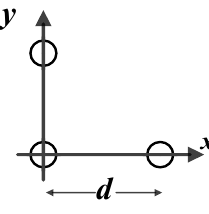
Figure 2. A traditional USBL orthogonal array diagram.